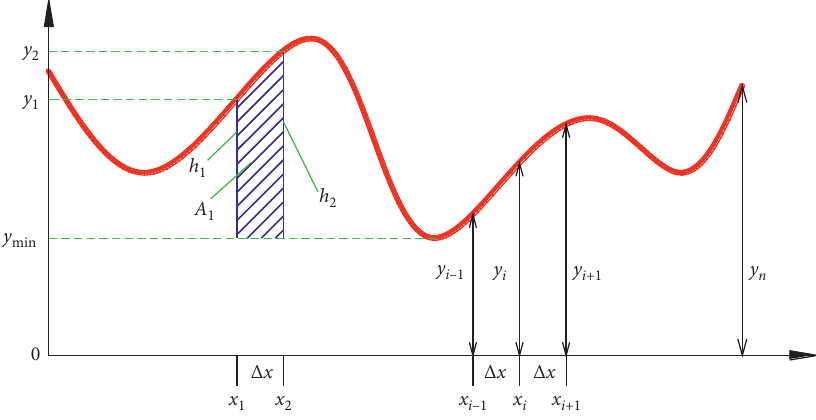
Figure 2: Schematic diagram of the area at microjoint